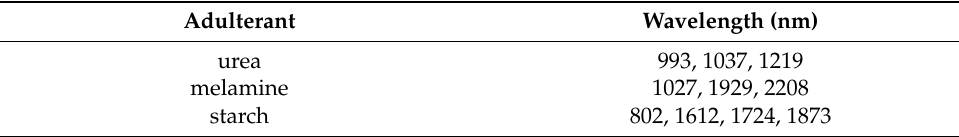
Table 3. Characteristic wavelengths selected by